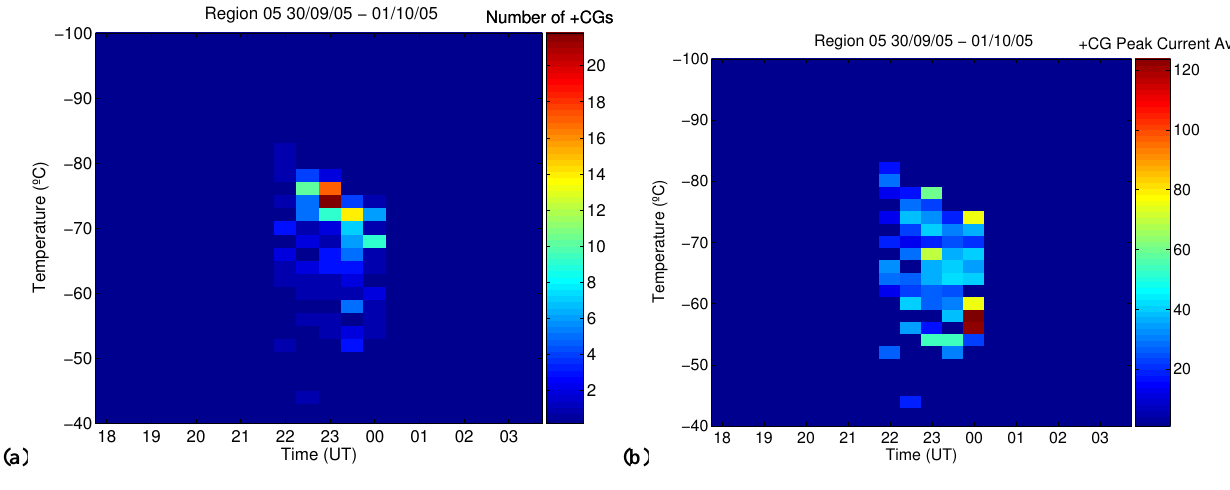
Fig. 11. Temporal spectrograms of +CG occurrence rate (a) and peak current (b) as a function of cloud top temperature, 30 September–1 October